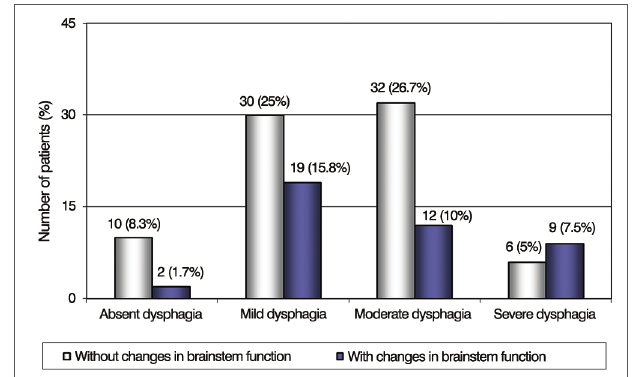
Figure 3. Patient Distribution according to the severity of dysphagia and changes in brainstem function in the Functional Disability Scale by Systems (EIFS).